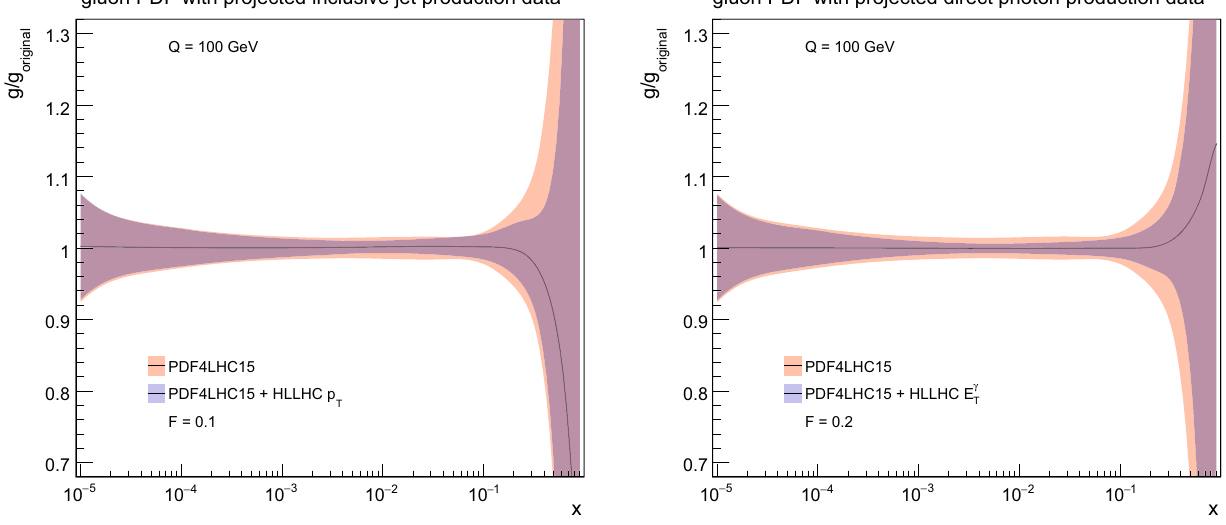
Fig. 10 As in Fig. 5, now for the central rapidity bins of the inclusive jet production (left plot) and the direct photon production (right plot) HL–LHC pseudo–data gluon PDF with projected inclusive jet production